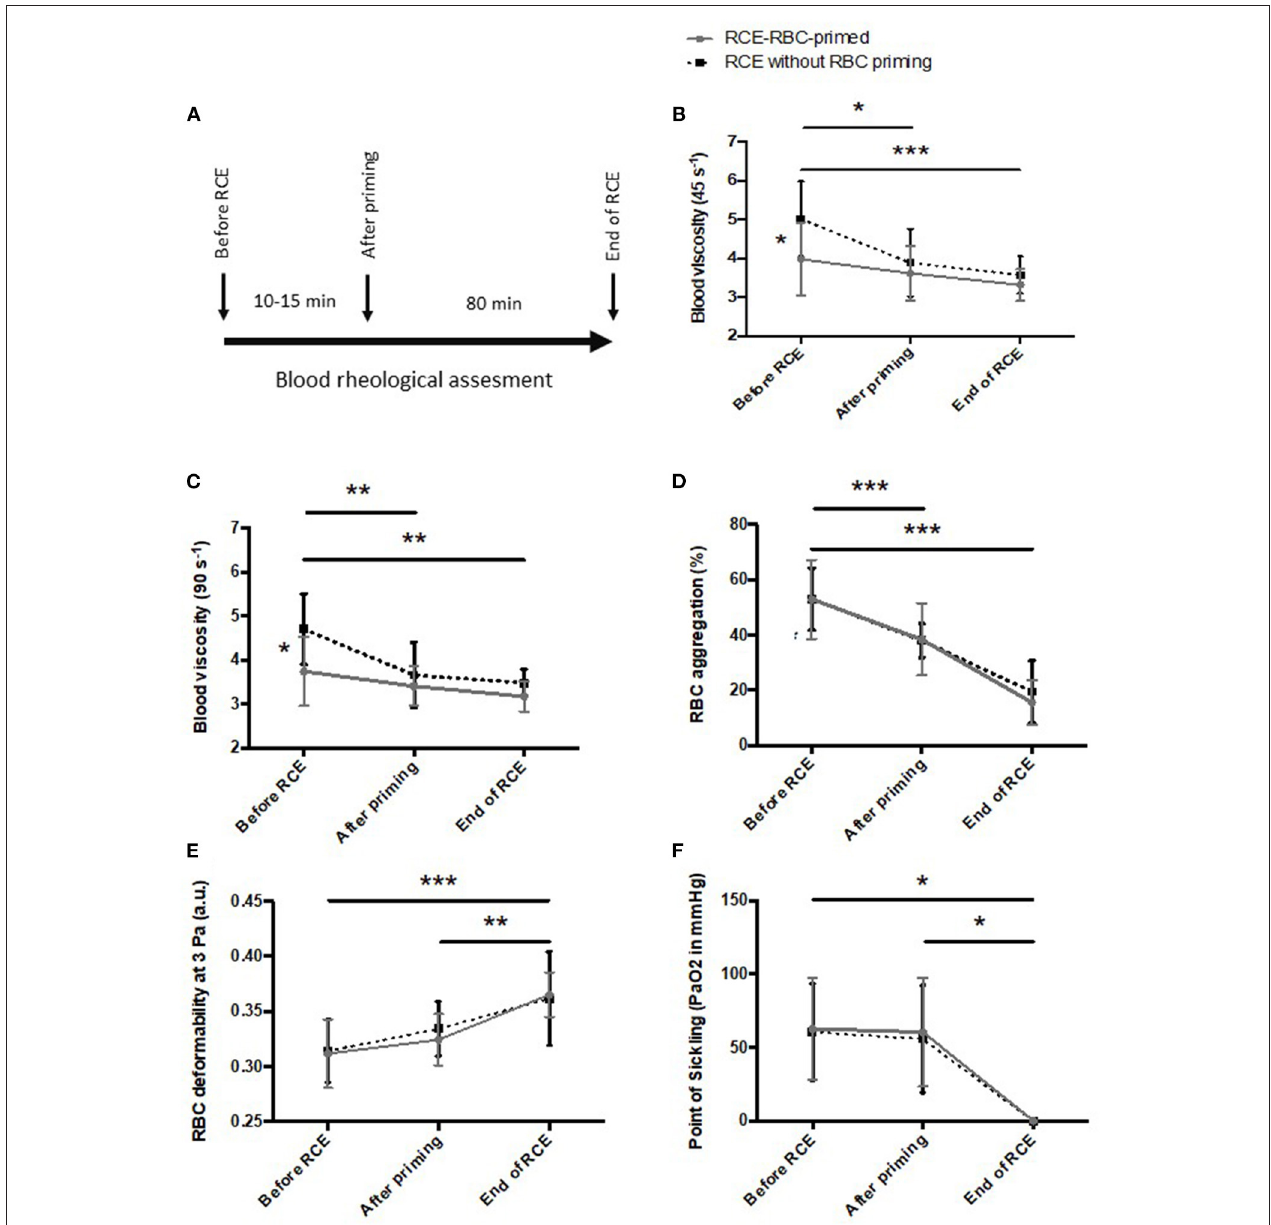
FIGURE 1 | Changes in blood rheological properties during red blood cell exchange/red blood cell (RCE/RBC)-primed vs. RCE without priming. (A) protocol; (B) blood viscosity at 45 s − 1 ; (C) blood viscosity at 90 s − 1 ; (D) RBC aggregation; (E) RBC deformability at 3Pa; (F) Point of sickling. Statistical difference: * p < 0.05; ** p < 0.01; *** p <